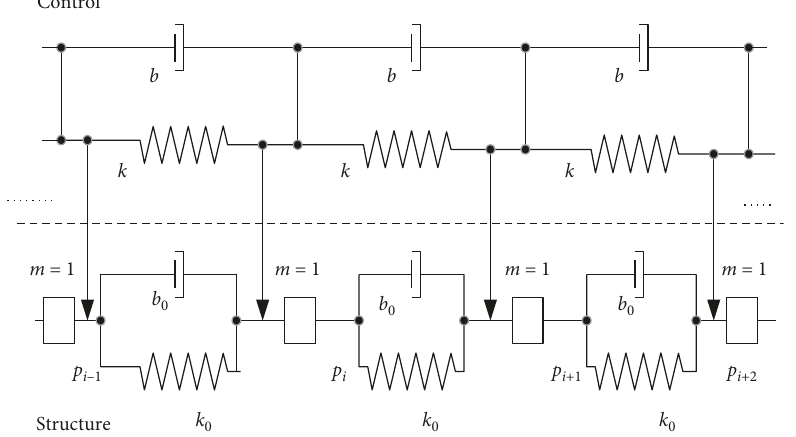
Figure 1: Distributed control law of a one-dimensional structure.